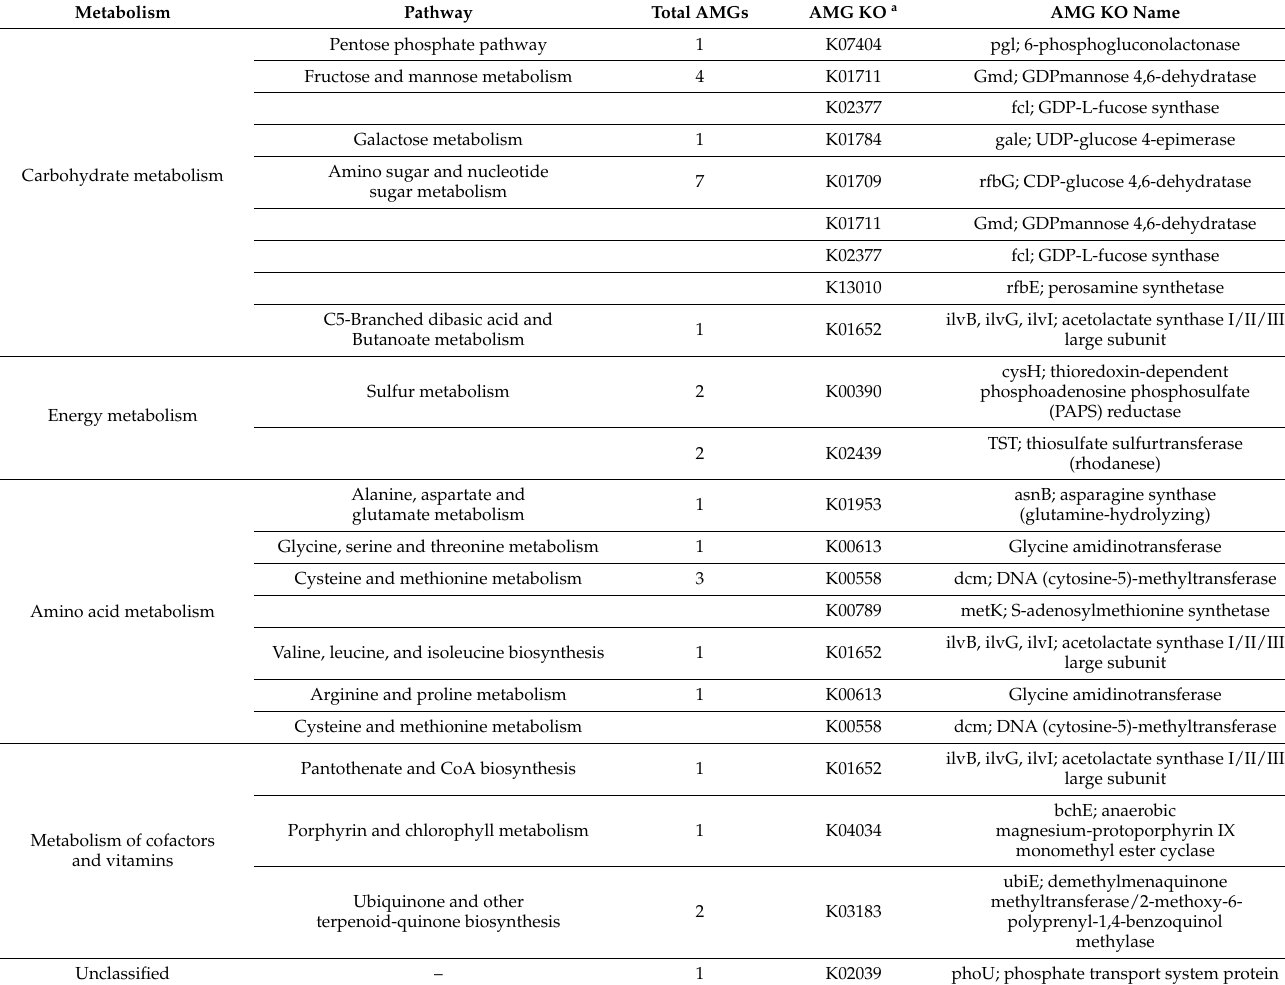
Table 1. Auxiliary metabolic genes identified in C. clathratiforme SAGs-associated viral contigs.